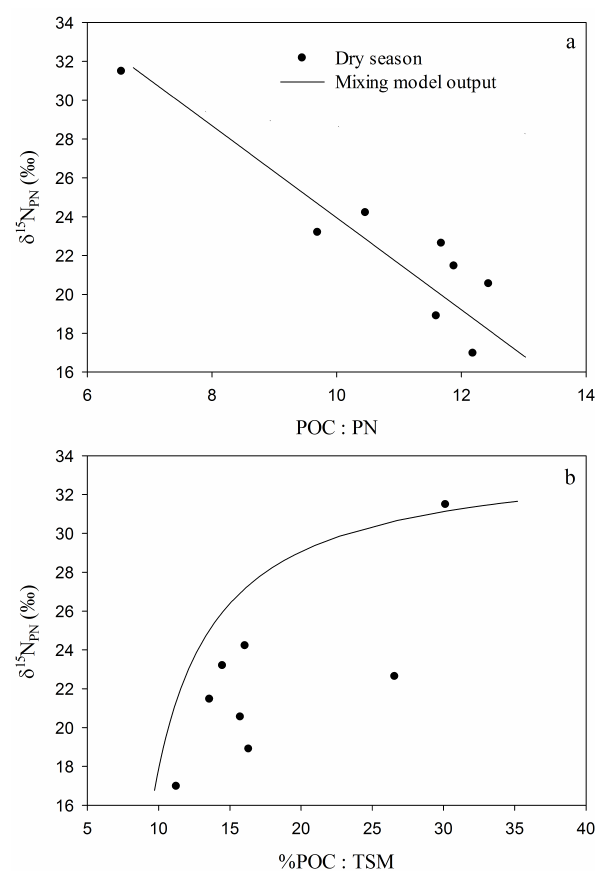
Fig. 11. Field measurements between S13 and S20 and mixing model output (solid line) for (a) POC:PN and δ 15 N PN , showing the preferential metabolism of phytoplankton biomass and associ- ated depletion of the δ 15 N PN pool downstream of the observed phy- toplankton blooms. The non-linear relationship between (b) %POC and δ 15 N PN supports the suggestion of rapid removal of the labile phytoplankton biomass downstream of